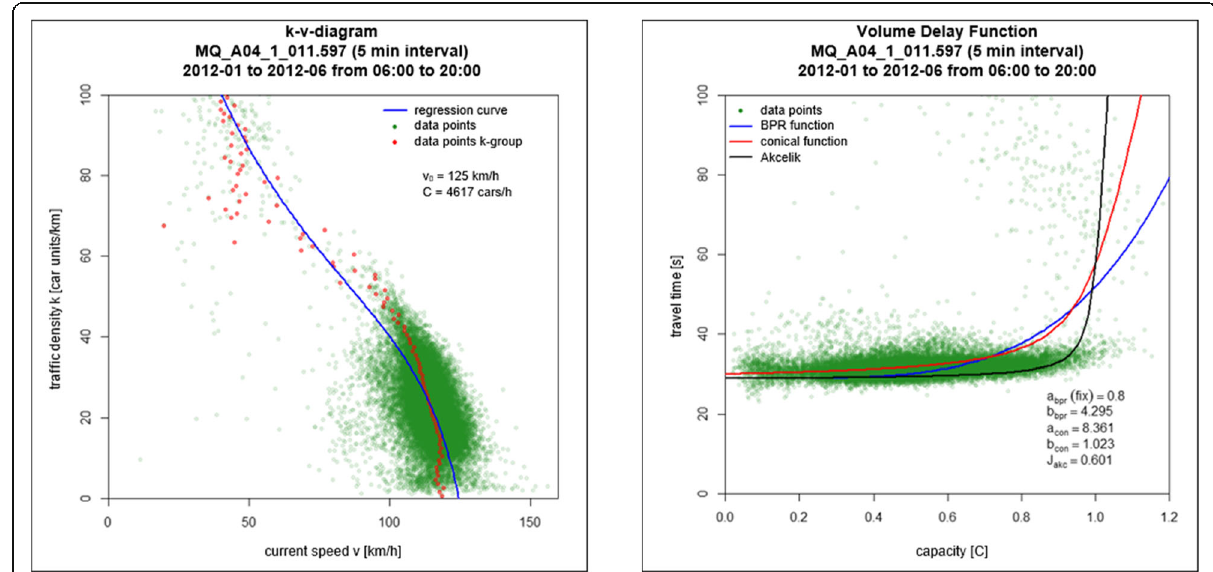
Fig. 7 k-v-diagram and Volume Delay function of the three-lane highway